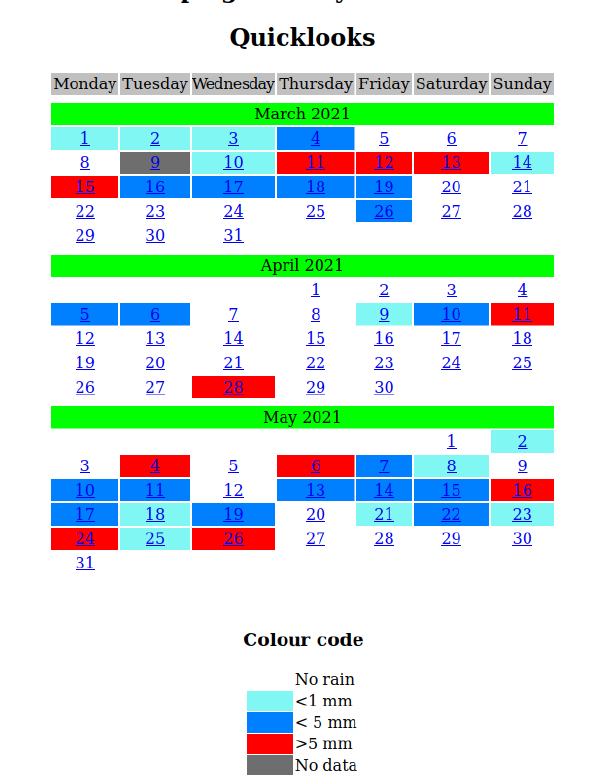
Figure 7. Snapshot of the calendar summarizing the March– May 2021 measurement campaign on the meteorological mast of the Pays d’Othe wind